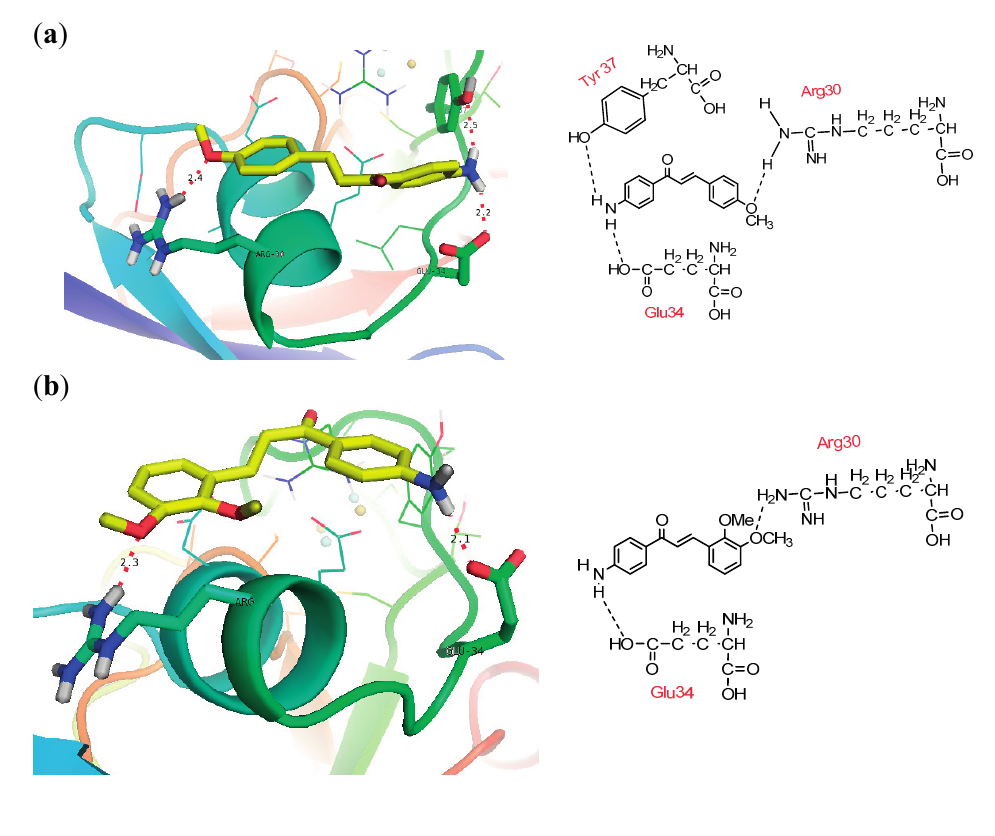
Figure 3. Docking pose and 2D presentation of the molecular interaction of the synthesized chalcones on Pf Fd and maize leaf-FNR. ( a ) Pf Fd-compound 3 , ( b ) Pf Fd-compound 4 ,